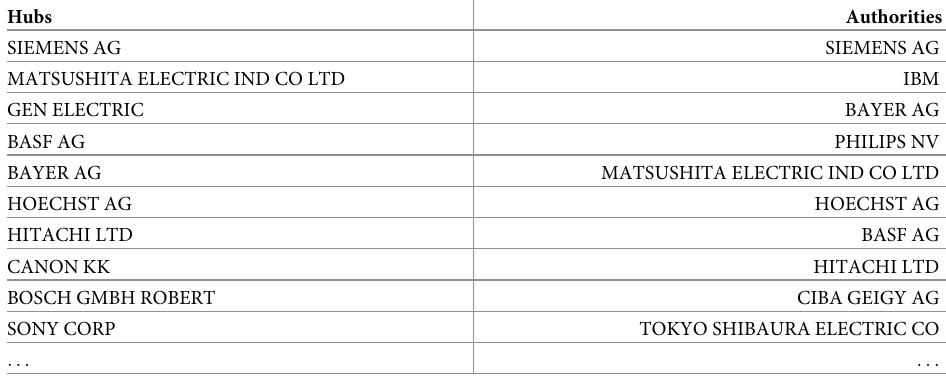
Table 9. Top-10 applicant hubs and